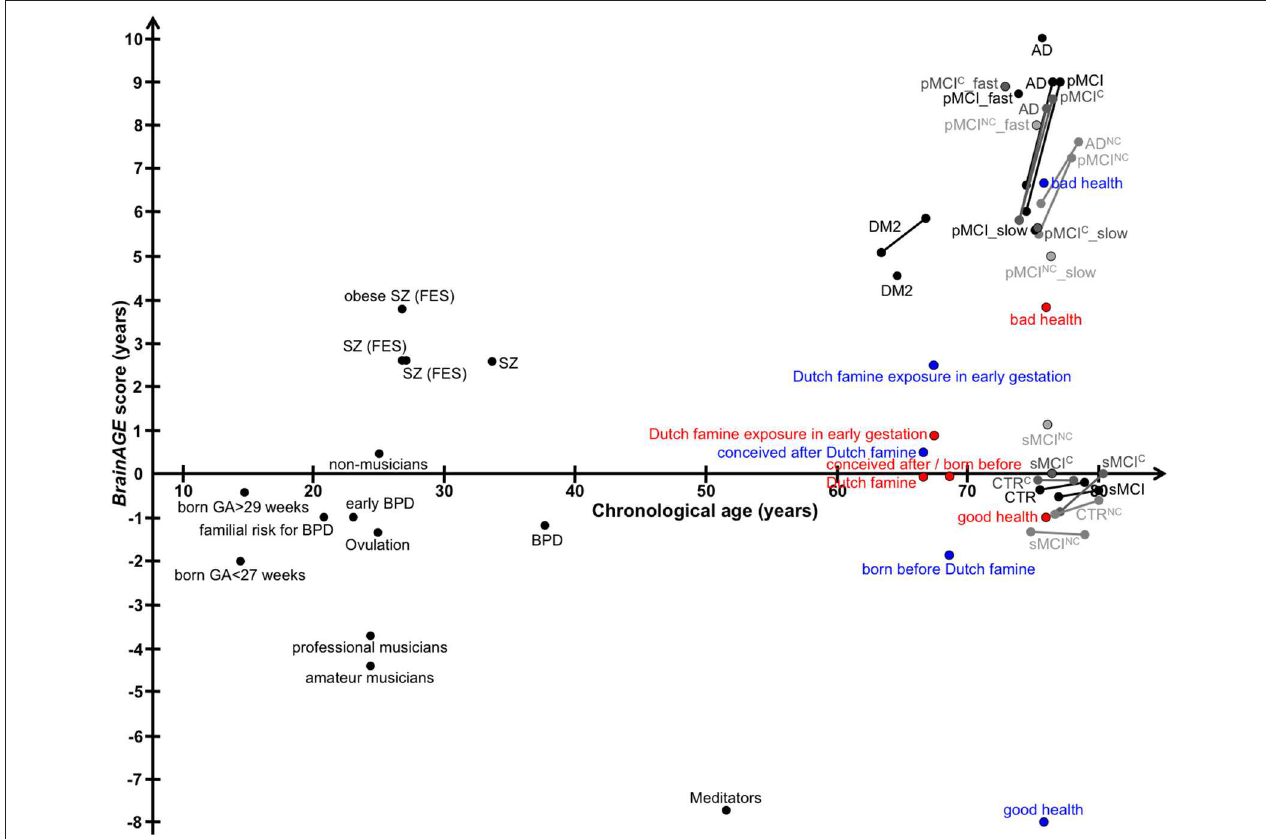
FIGURE 12 | Graphical summary of BrainAGE results in human studies. Dots, study means; Lines, longitudinal results; Blue, males; Red, females. [AD, Alzheimer’s disease; BPD, bipolar disorder; CTR, control subjects; DM2, diabetes mellitus type 2; FES, first episode of schizophrenia-spectrum disorders; GA, gestational age; MCI, mild cognitive impairment; pMCI, progressive MCI (i.e., convert from MCI to AD during follow-up); pMCI_fast, diagnosis was MCI at baseline, conversion to AD within the first 12 months (without reversion to MCI or CTR at any available follow-up; pMCI_slow, diagnosis was MCI at baseline, conversion to AD was reported after the first 12 months of follow-up (without reversion to MCI or CTR at any available follow-up); sMCI, stable MCI (i.e., diagnosis is MCI at all available time points, but at least for 36 months); SZ,